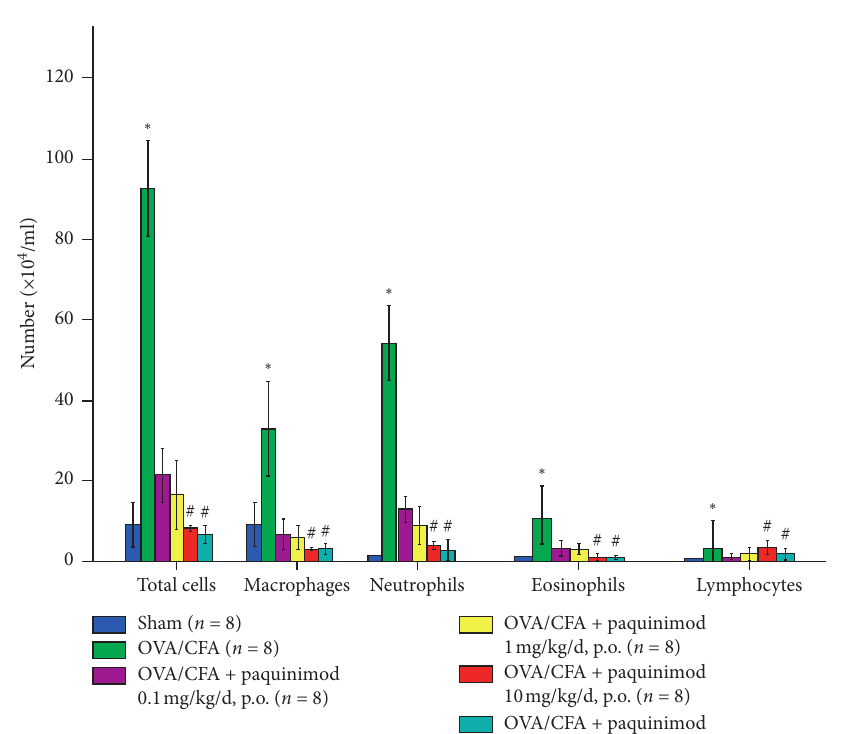
Figure 1: Effect of paquinimod on inflammatory cell number of CFA/OVA-treated mice. The numbers of BAL cells are shown as the mean ± SEM ( × 10 4 /mL). ∗ P < 0 . 05 compared with the sham group; # P < 0 . 05 compared with the OVA/CFA group. The P value was obtained using the Kruskal–Wallis test and the post hoc Mann–Whitney U